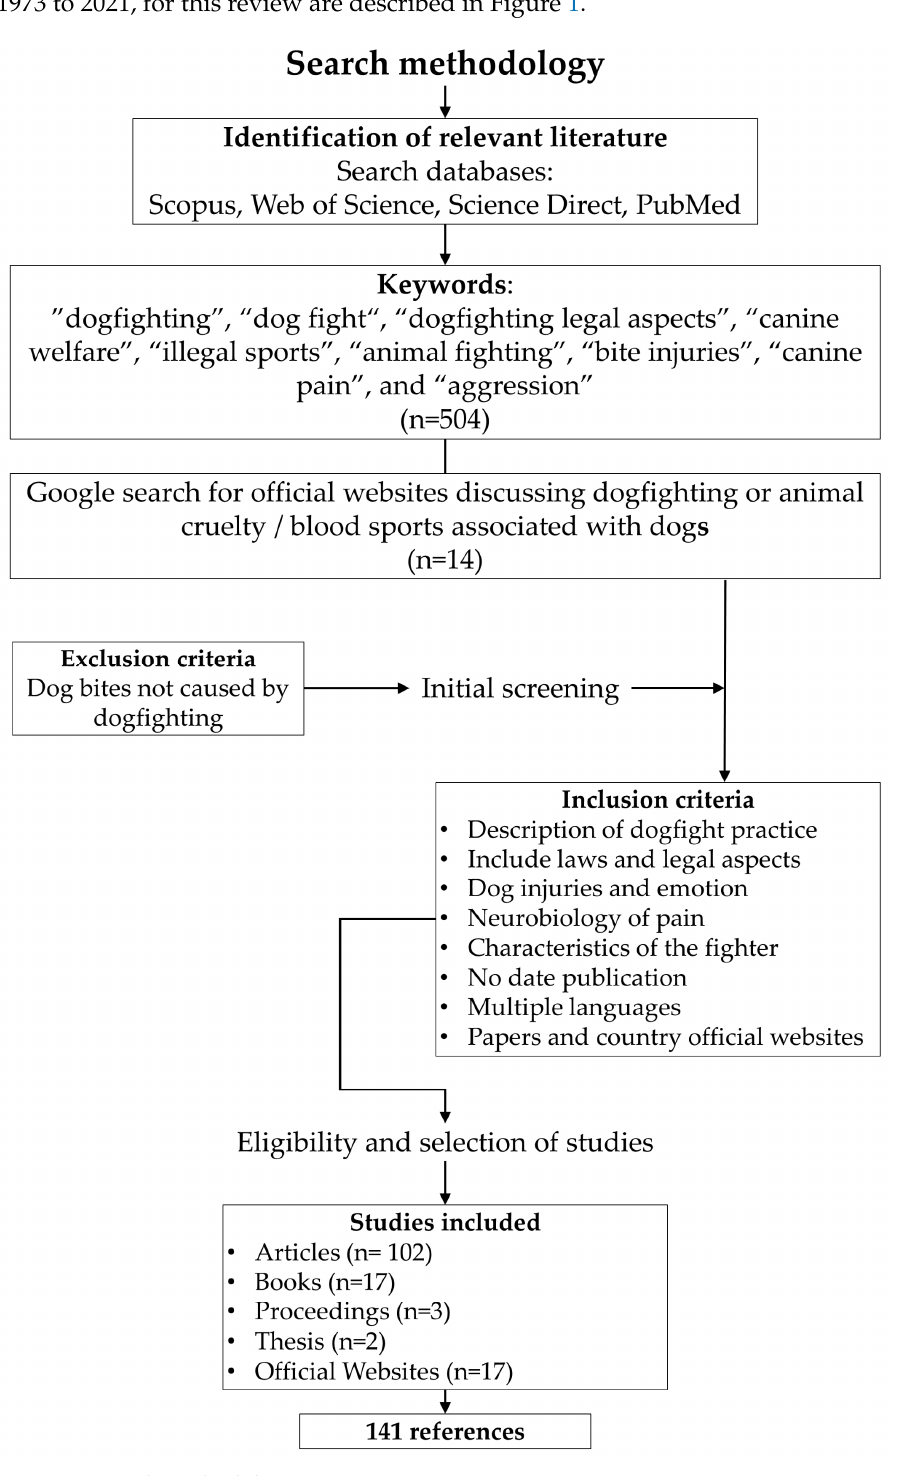
Figure 1. Search Figure 1. Search methodology.